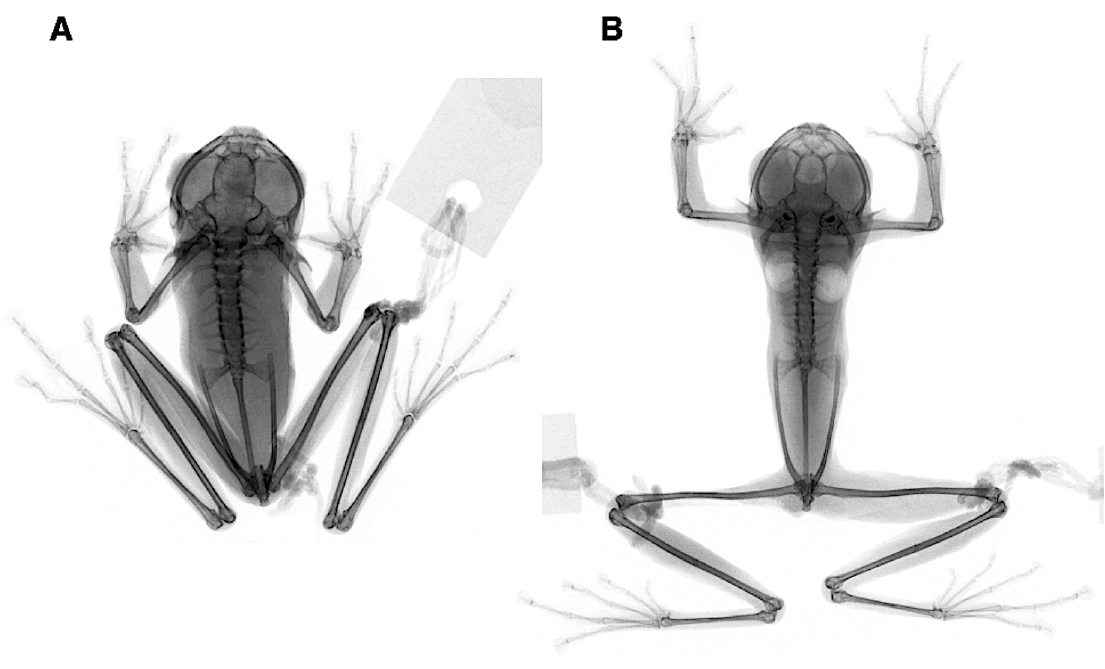
Figure 85. Humeral spines of Espadarana audax and E. durrellorum . ( A ) Espadarana audax , KU 164500. ( B ) Espadarana durrellorum , QCAZ 47909. Photos by Juan M. Guayasamin. Variation: In several males, the dorsal spicules are minute and only visible under magnification. A population from Leonidas Plaza Gutiérrez (Limón) has a dorsum with very few and small dorsal yellow spots. Color in life (Figure 83): Dorsum green, with small yellow spots; fingers and toes pale yellow; parietal peritoneum white; heart not visible; visceral peritoneum lacking iridophores. Ventral